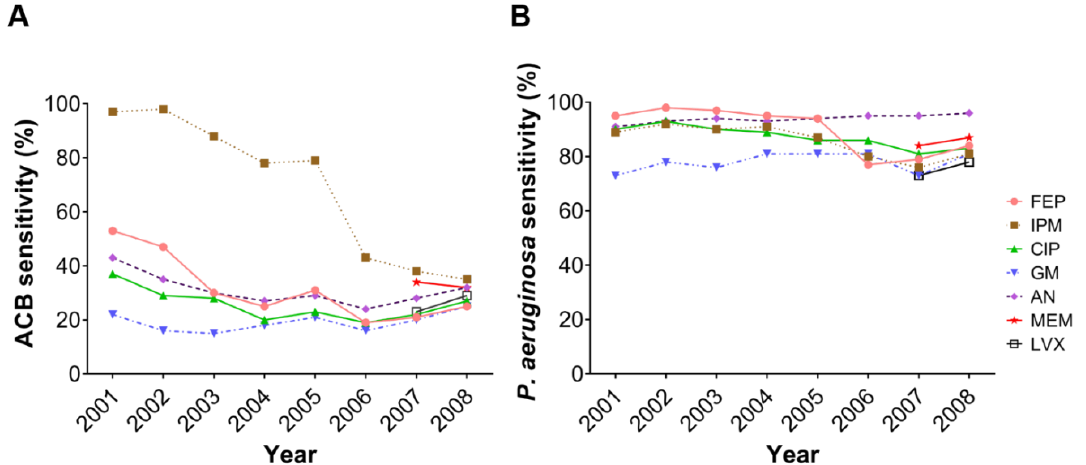
Figure 2. The prevalence of antimicrobial sensitivity for ACB and P. aeruginosa . ( A ) ACB and ( B ) P. aeruginosa were isolated from inpatients and outpatients in China Medical University Hospital (CMUH) from 2001 to 2008. The prevalence of sensitivity to each antibiotic was analyzed: AN, amikacin; CIP, ciprofloxacin; FEP, cefepime; GM, gentamicin; IPM, imipenem; LVX, levofloxacin; MEM,